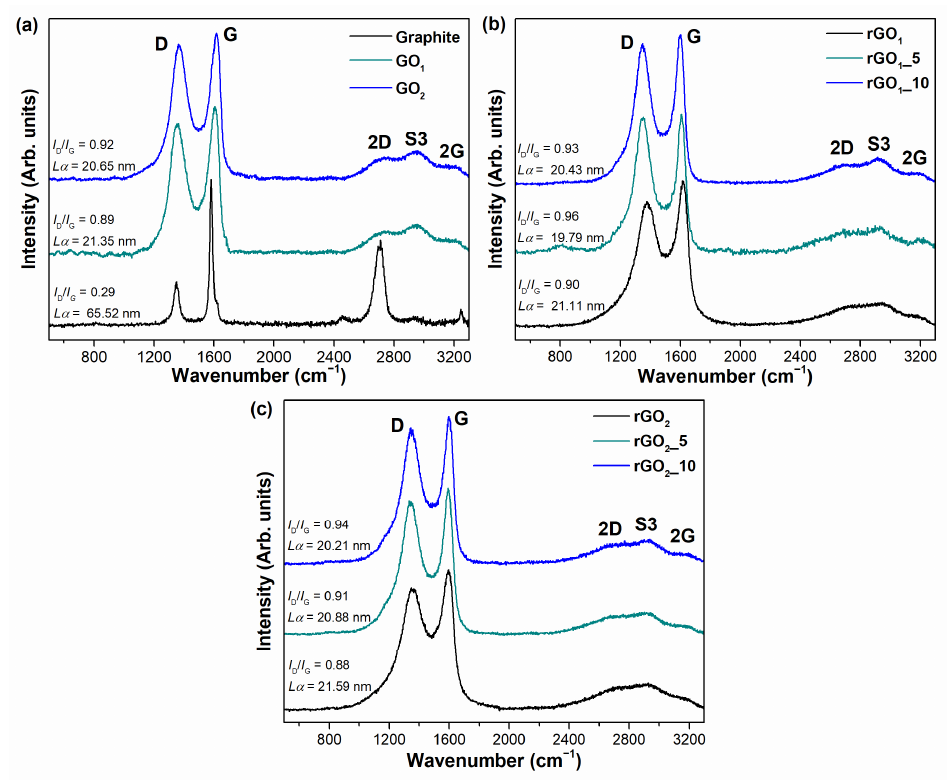
Figure 4. Raman spectra of graphite, GO 1 , and GO 2 ( a ); thermally reduced samples derived from GO 1 ( b ); and thermally reduced samples derived from GO 2 ( c ). The excitation wavelength is 532 nm.